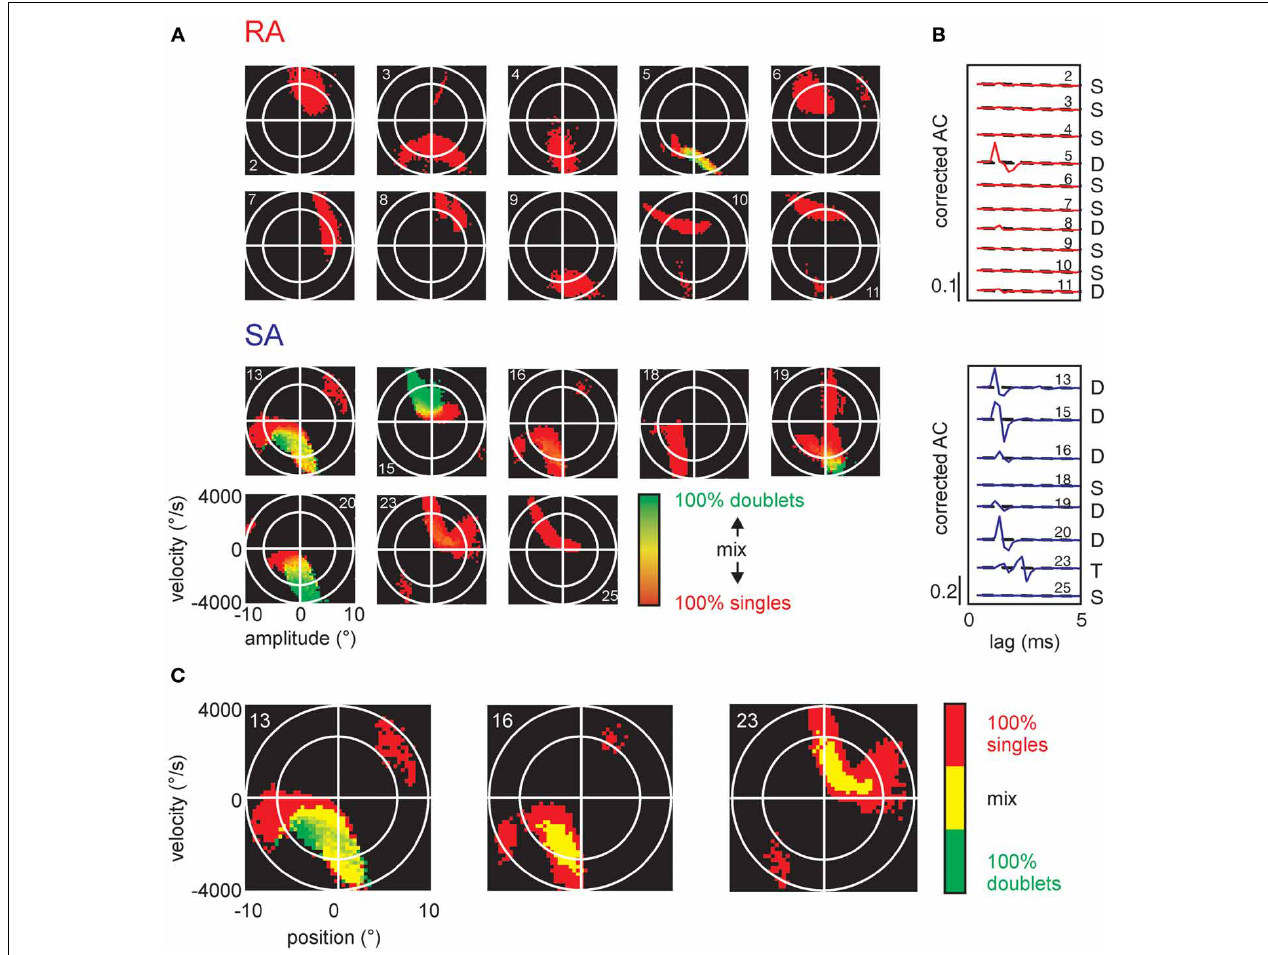
FIGURE 7 | Stimulus encoding of single spikes and doublets for all cells in the sample. (A) Conventions as in Figure 6D , all cells in the sample. (B) Corrected autocorrelograms of all cells in the sample. Ordinate scales correlation coefficient ( r ). (C) The SA cells (numbers 13, 16, and 23) are re-plotted in a different color